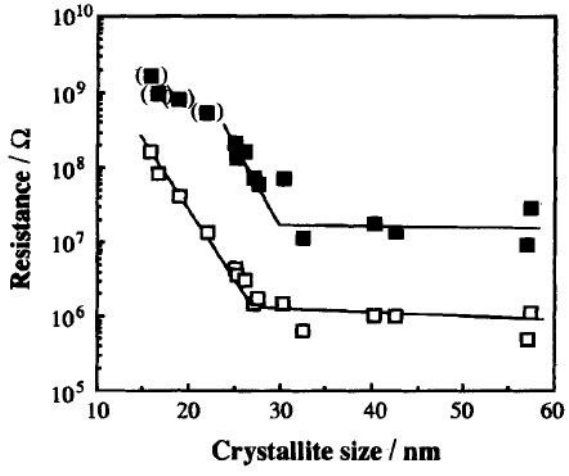
Figure 16. The variation in resistance according to WO (cid:2) 5 ppm NO in air at 300 °C. Figure adapted with permission from 2